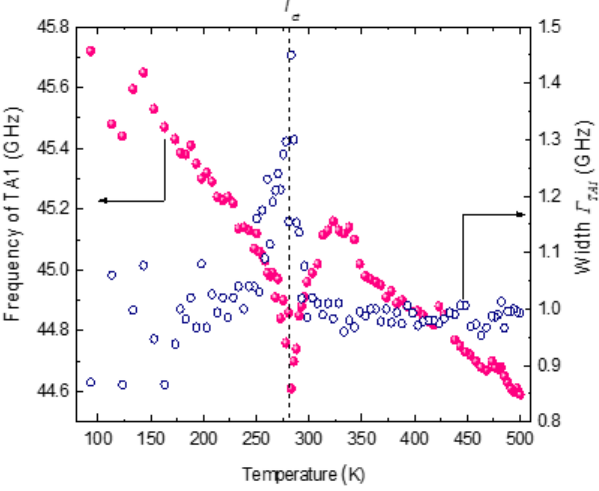
Figure 19. Temperature variation in thefrequency and the width of TA1 phonon mode. (Reprinted with kind permission from Ref. [83]. Copyright (2020) The Japan Society of Applied Physics).